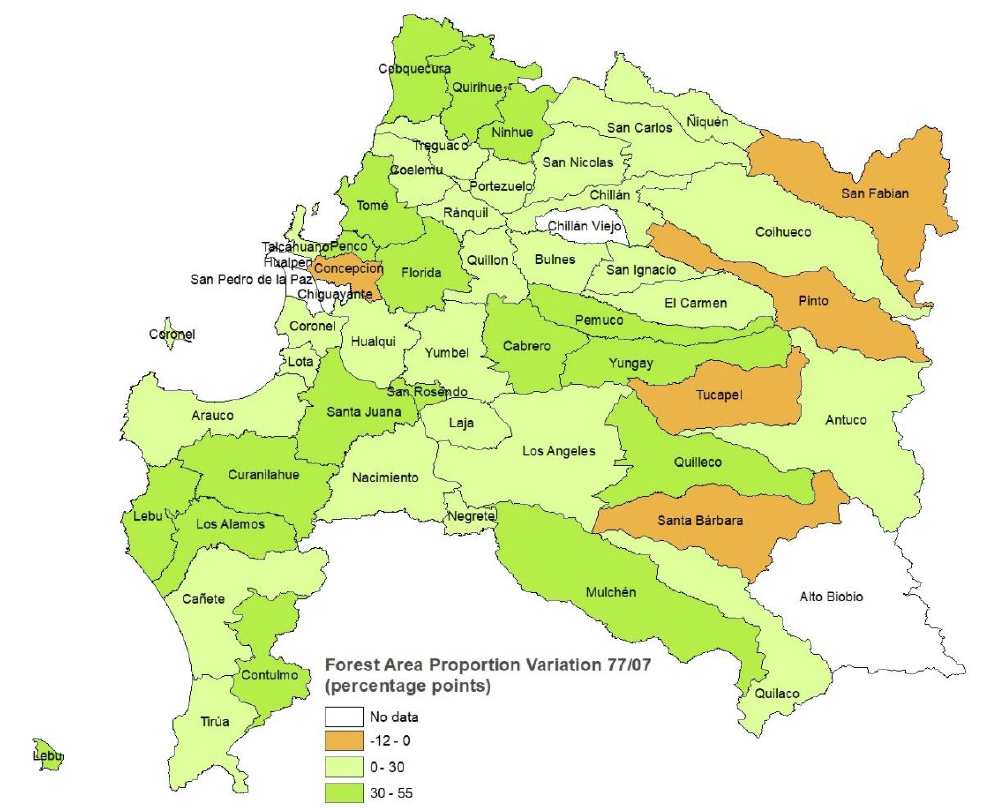
Figure 4. Inter-census variation (1977–2007) of forest land area by county in percentage points.